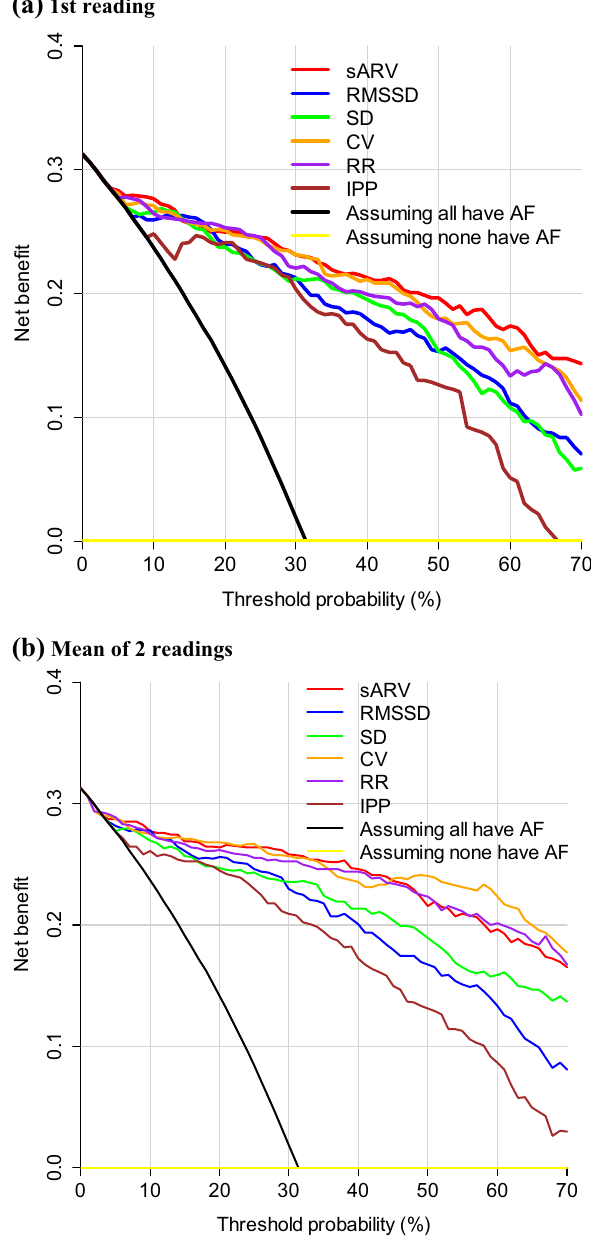
Figure 2. Decision curves for AF detection by pulse rate variability parameters with the: ( a ) 1st reading and, ( b ) mean of 2 readings. Abbreviations are as for Fig.